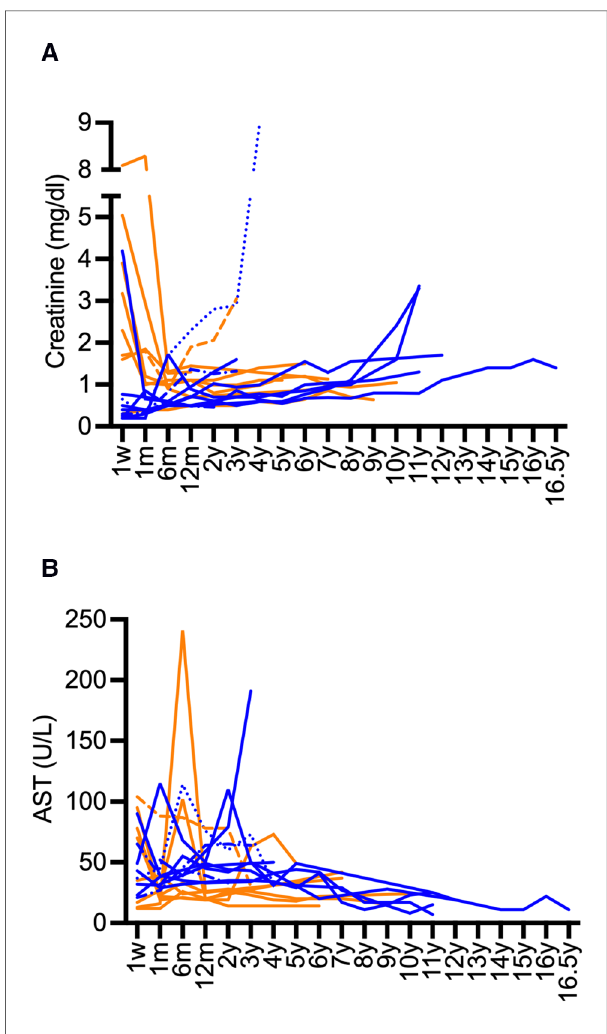
FIGURE 2 Long-term course serum-creatinine and AST after CLKT. ( A ): serum- creatinine (infantile PH1: blue, juvenile PH1: orange), ( B ): AST (infantile PH1: blue, juvenile PH1: orange); Patient 1 ( ——— ) and patient 3 (······): creatinine values and AST after fi rst CLKT are shown, patient 2 (-·-·-): data after second CLKT and third CLKT are shown, patient 13 (fatal case) is not